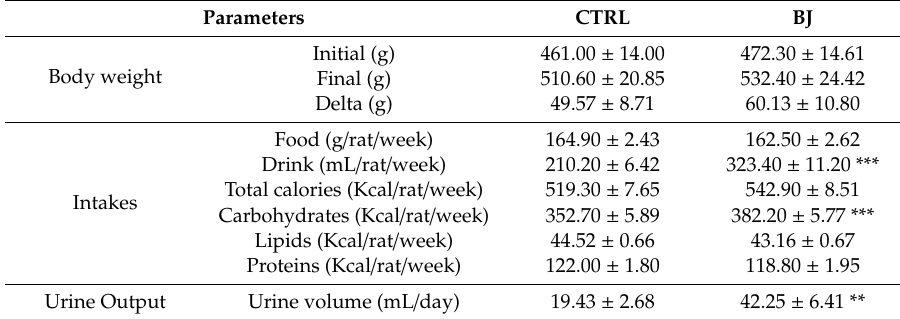
Table 2. BW variation and cumulative energy intake during the experimental protocol.